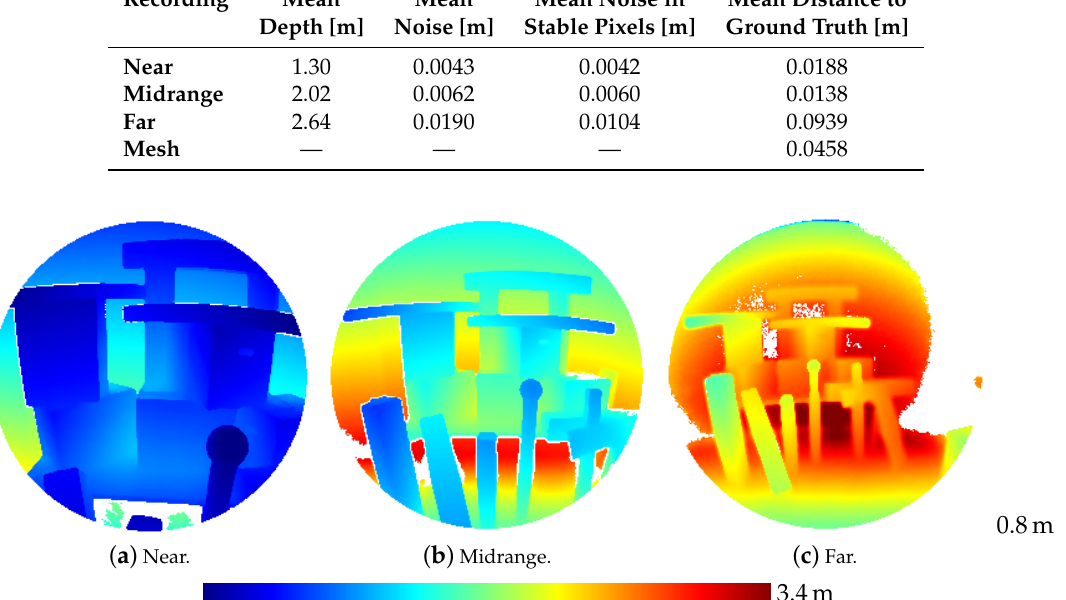
Figure 9. Depth images derived from the HoloLens ToF sensor for the three-dimensional scene depicted in Figure 5 captured from three different distances.